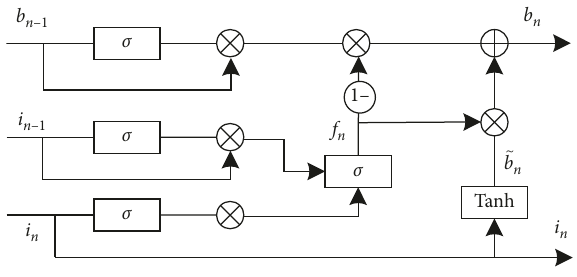
Figure 2: Causal gated recurrent unit (CGRU). Figure 1: Gated recurrent unit